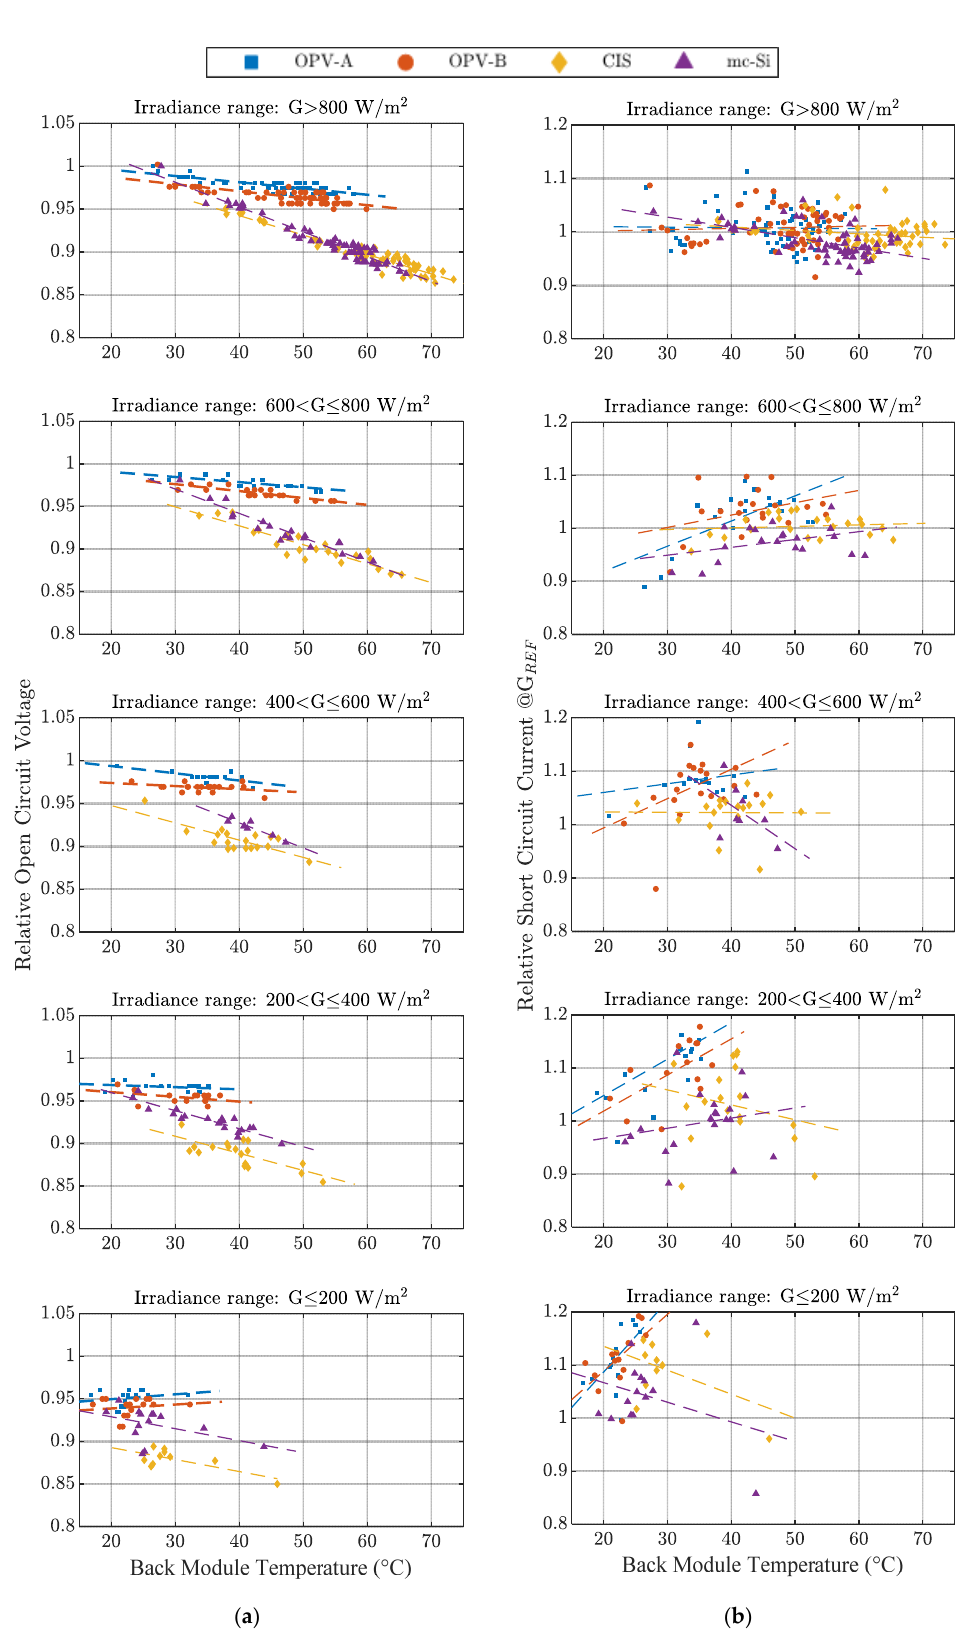
Figure 5. Relative open-circuit voltage ( a ) and relative short-circuit current ( b ) as a function of the back module temperature for the whole set of PV modules under test.